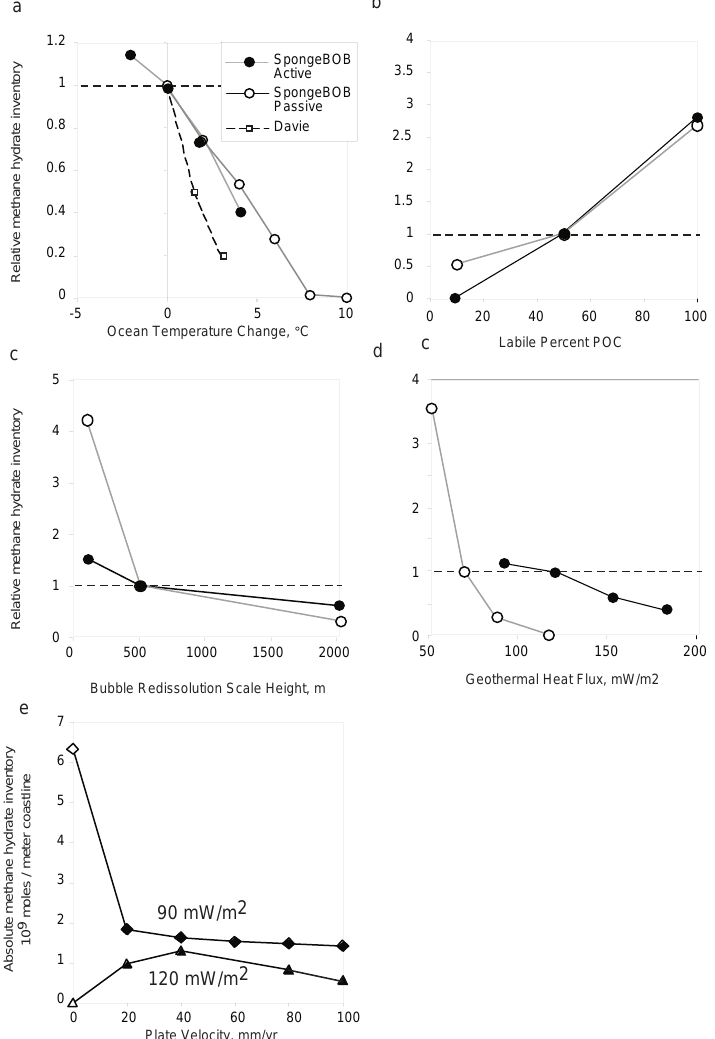
Fig. 17. Summary of model sensitivities: (a) ocean temperature, (b) labile fraction of POC, (c) bubble redissolution scale height, (d) geother- mal heat flux, and (e) plate velocity (with zero velocity case taken from the passive margin simulation) (Archer et al.,